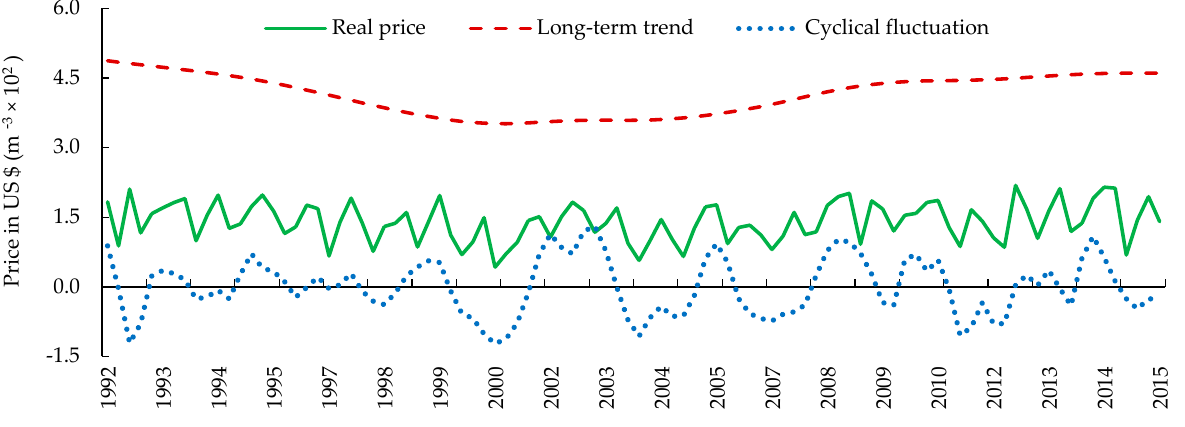
Figure 1. Decomposition of time series of sawlog price, including a real price as well as long-term trend and cyclical fluctuation.